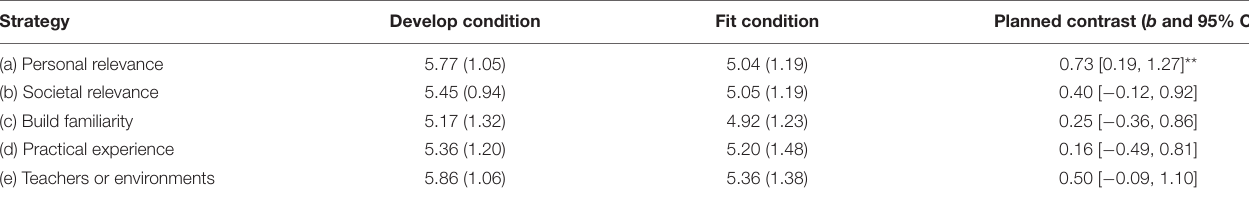
TABLE 4 | Study 3 group means (Standard Deviations) and regression contrasts comparing participants’ cultivation strategy-use intentions between the Develop and Ft conditions 1 year later. Strategy Develop